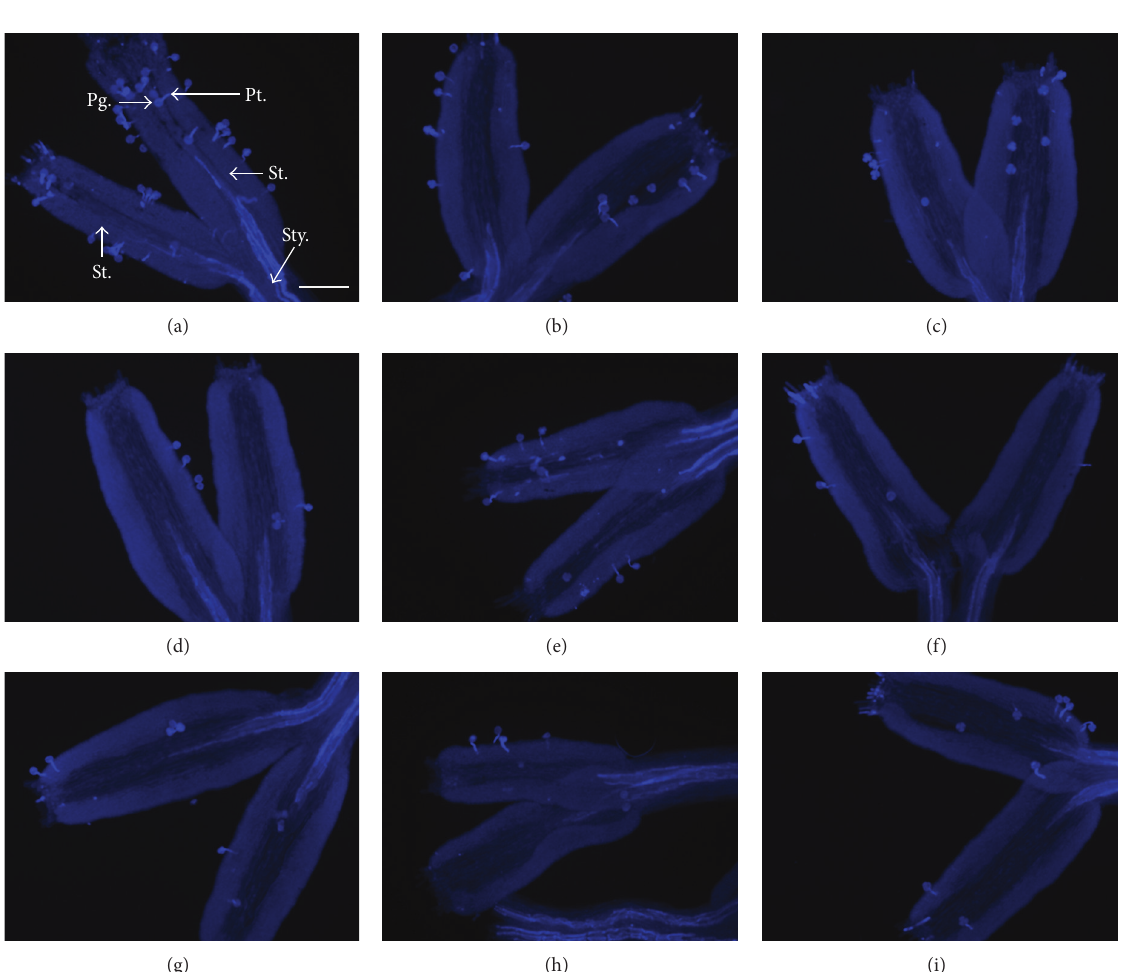
Figure 3: Germination behaviour of pollen grains on stigmas of nine “Q10-33-1”s progeny at 24 hours after self-pollination. ((a)–(i)) Q10-33- 1 A – 0 . Abbreviations: Pg.: pollen grain, Pt.: pollen tube, St.: stigma, and Sty.: style. All the figures have the same bar (100 𝜇